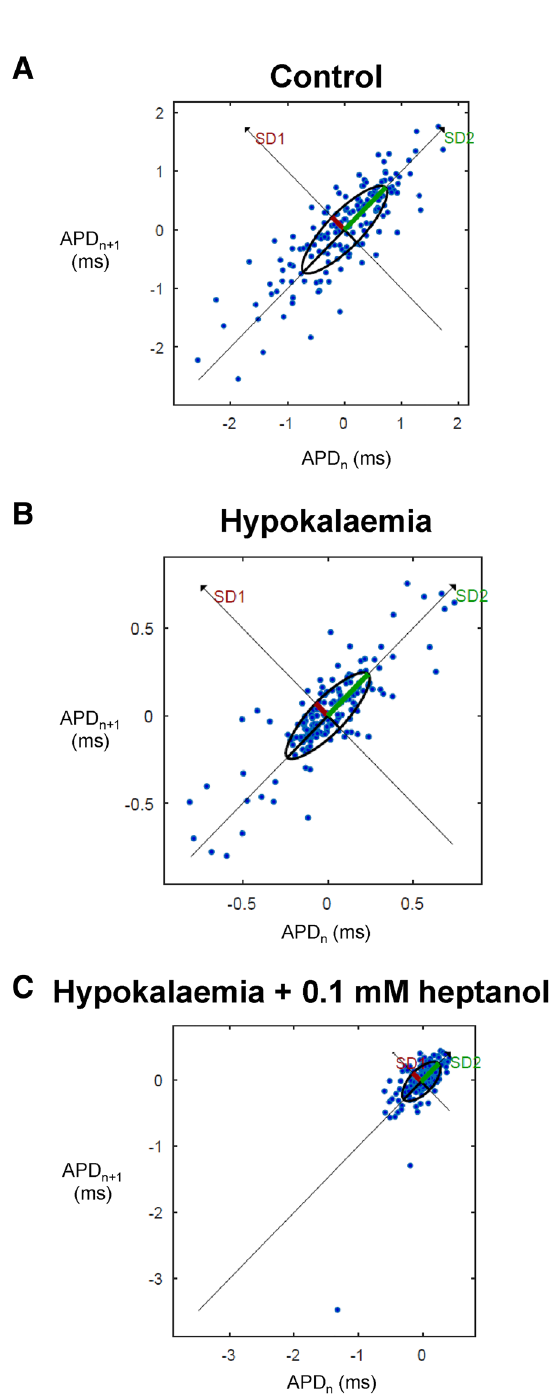
Fig. 5 Representative Poincaré plots of APD n against APD n with SD along the line-of-identity (SD1) and SD perpendicular to the line-of-identity + 1 (SD2) before ( A ) or after the application of experimental hypokalaemia ( B ) and hypokalaemia with 0.1 mM heptanol ( C ) ( n